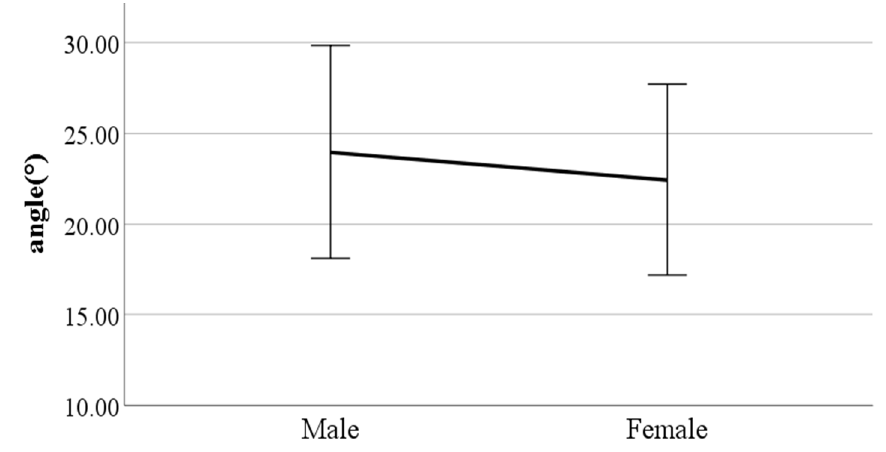
Figure 9. Gender difference in the ratio of swing phase (F value: 0.31, DF: 289, p -value: 0.04).